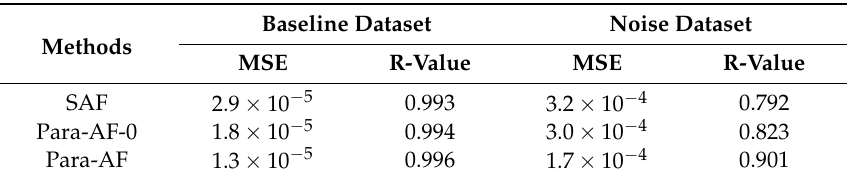
Table 1. Evaluation results for SAF and the proposed